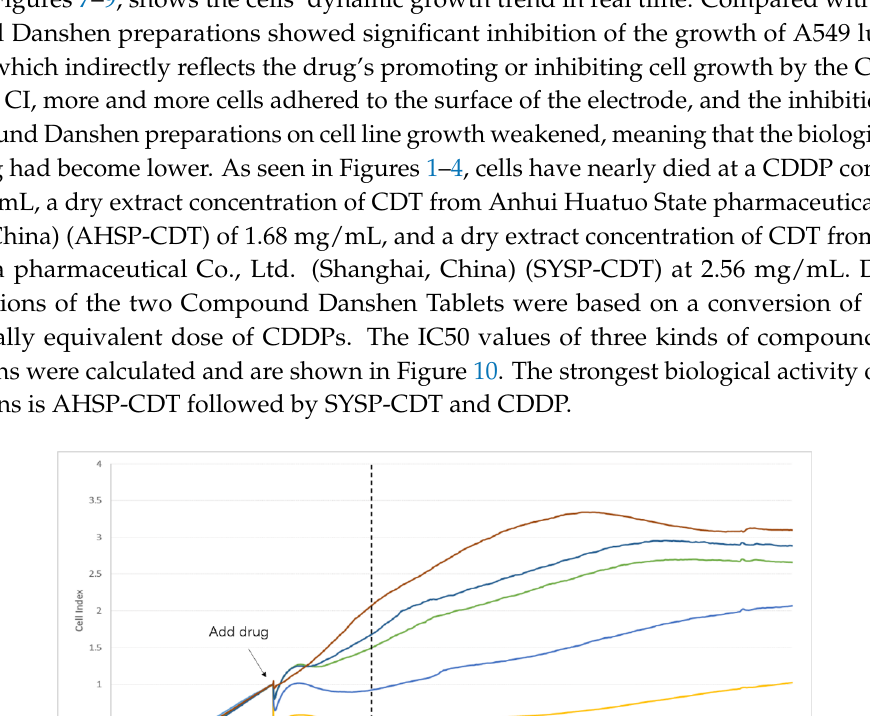
Figure 7. The time/dose-dependent cell response profiles (TCRPs) of the different concentration samples of CDDPs acting on A549 cells plotted against time with the mean of three experiments. The concentrations are: 3.60 mg/mL (light blue line), 2.88 mg/mL (medium brown line), 2.30 mg/mL (gray line), 1.84 mg/mL (yellow line), 1.47 mg/mL (medium blue line), 1.18 mg/mL (green line), 0.95 (dark blue line), and control (dark brown line).